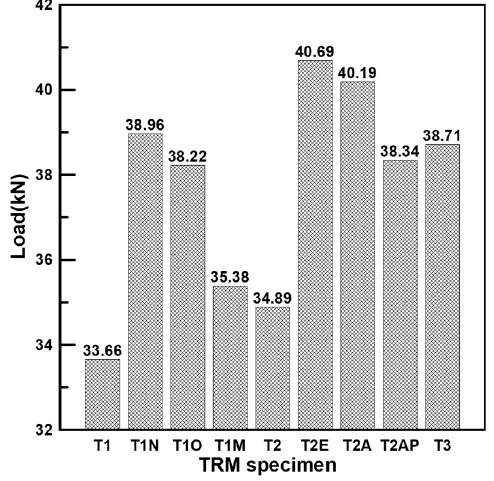
Figure 13. Comparison of yield loads of TRM specimen.